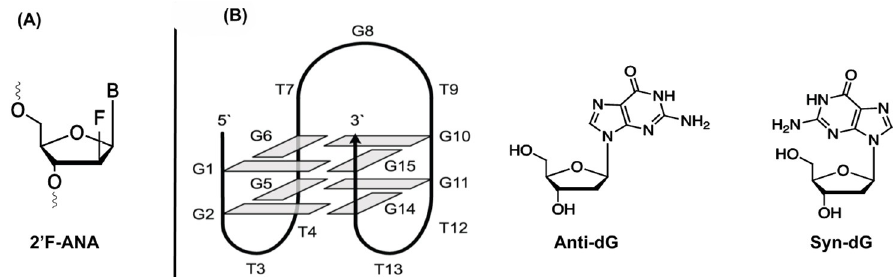
Figure 10. Structure of 2′F-ANA nucleosides ( A ); Structure of the thrombin binding aptamer with an edge-loop G-quadruplex conformation and the anti- and syn-oriented deoxyguanosine ( B ). Reprinted (adapted) with permission from Chemistry Central Journal, 2014, 8, 19—Published by Springer Nature. Creative Commons. License link available online: https://creativecommons.org/licenses/by/2.0.